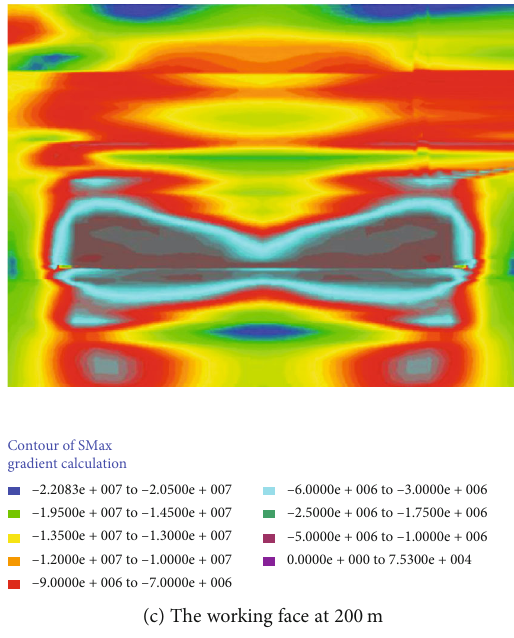
Figure 10: Stress distribution of